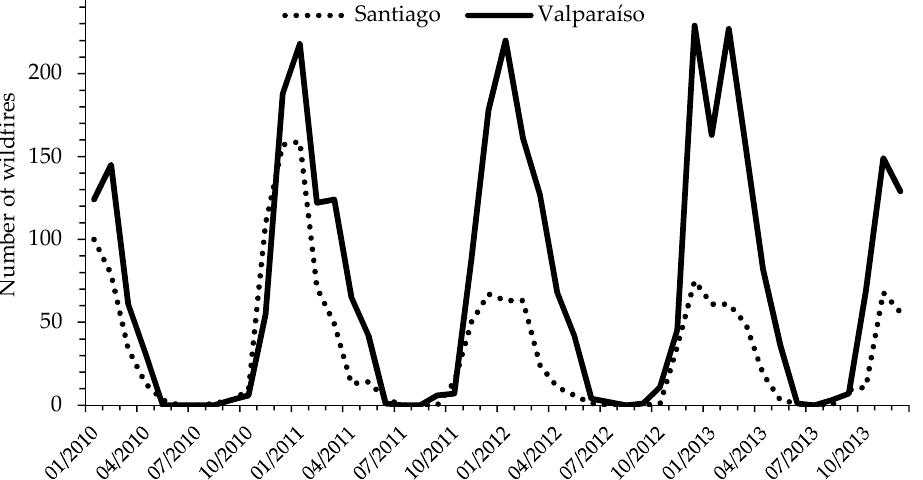
Figure 2. Temporal trend of the number of wildfires in Valparaíso and Metropolitan regions from January 2010 to December 2013.